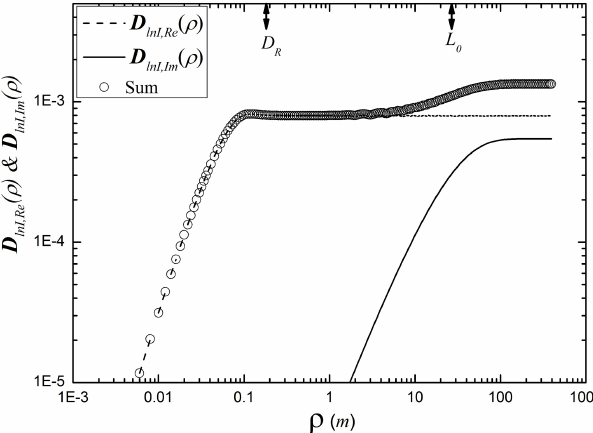
Figure 2. The temporal structure functions ( D ln I, Re (ρ) and D ln I, Im (ρ)) of the logarithmic light intensity fluctuations due to the real and imaginary parts of the ARISP, calculated with the same parameters used in Fig. 1. The two arrows in the figure denote the values of the diameter of the transmitter (or receiver) and the outer scale to assist in comparison with different